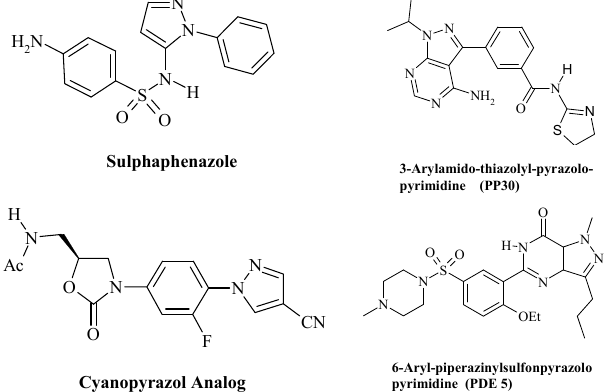
Figure 1. Antimicrobial agents containing pyrazole moiety; pyrazolopyrimidine scaffold based potential candidates and drugs.